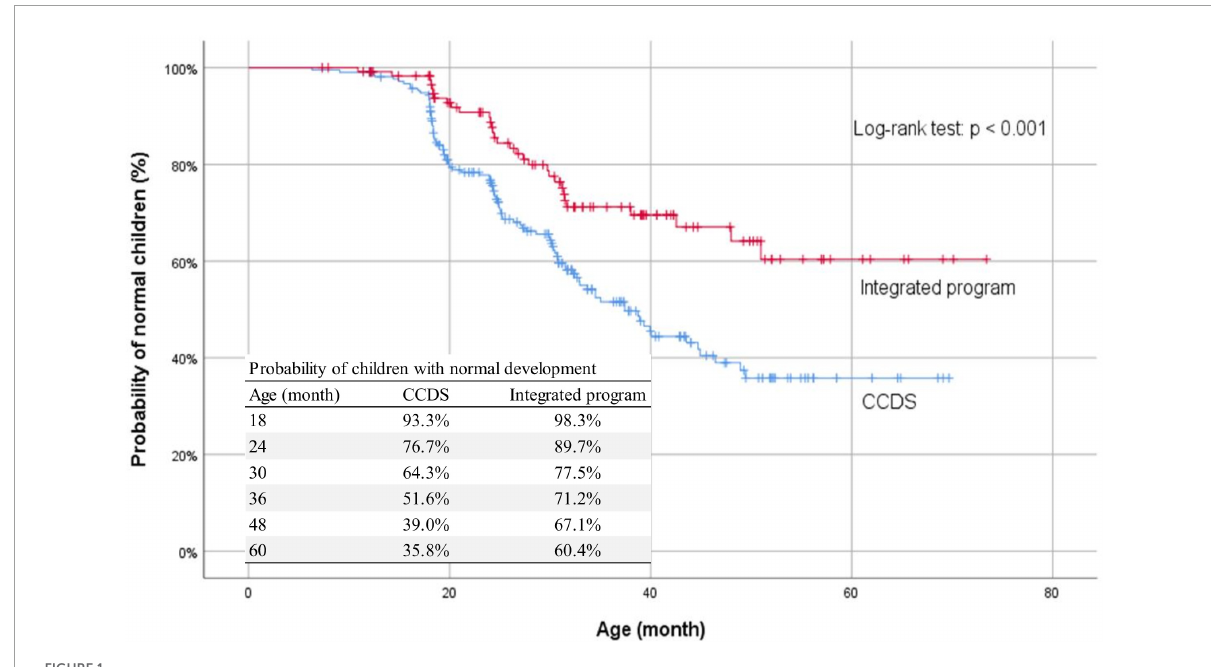
FIGURE1 Kaplan-Meier curve on any developmental delay for CCDS and integrated